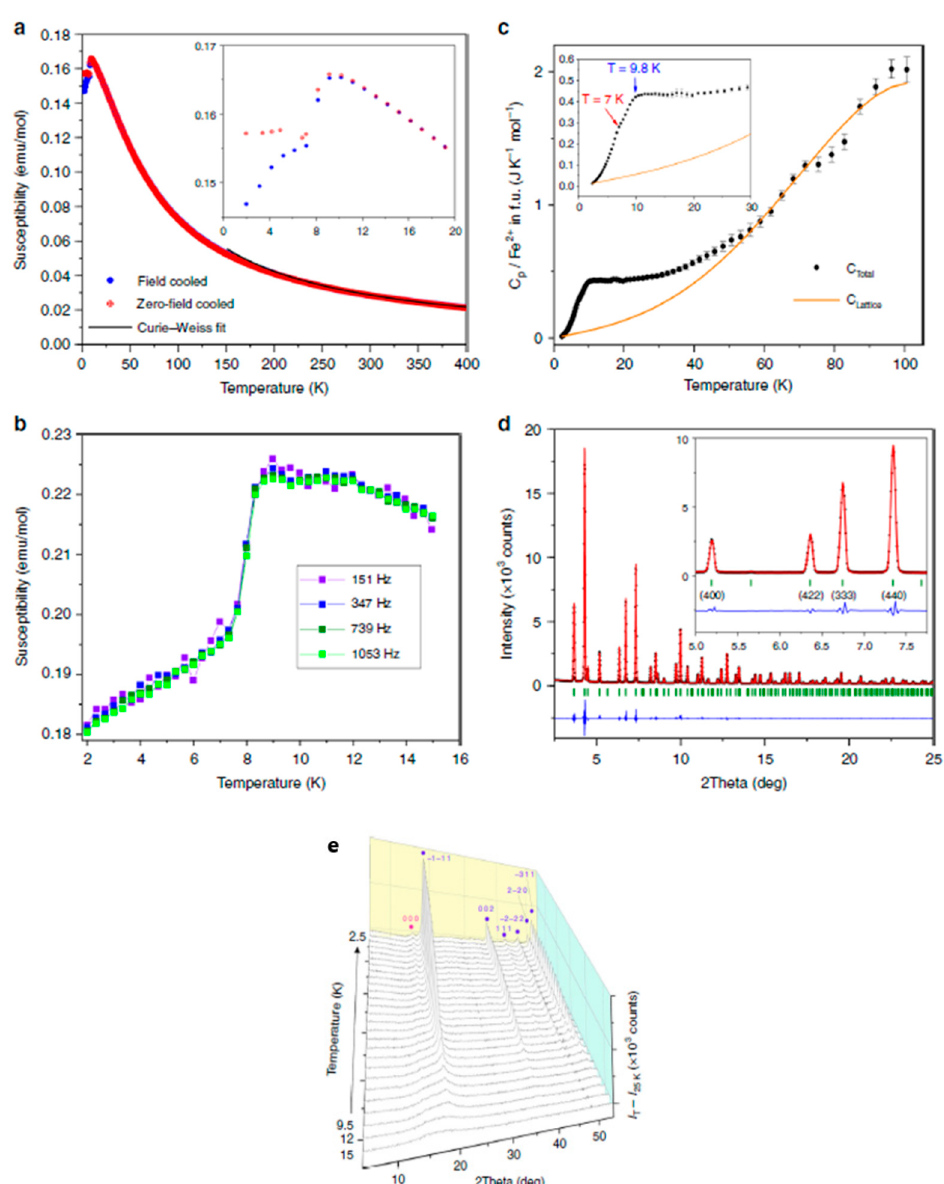
Figure 7. ( a ) Magnetic susceptibility in an applied field of 0.5 T (inset showing the low-temperature region); ( b ) Real part of the AC susceptibility in an oscillating magnetic field with amplitude 9 Oe at different frequencies; ( c ) Heat capacity variation with the lattice contribution fit. The inset shows the low-temperature region (error bars are standard deviations); ( d ) Fit of the synchrotron X-ray diffraction profile at 5 K; ( e ) Magnetic scattering profiles from neutron diffraction data at different temperatures. hkl labels correspond to magnetic satellite reflections with different propagation vector [25]. Reproduced with permission, Copyright Springer Nature 2018.